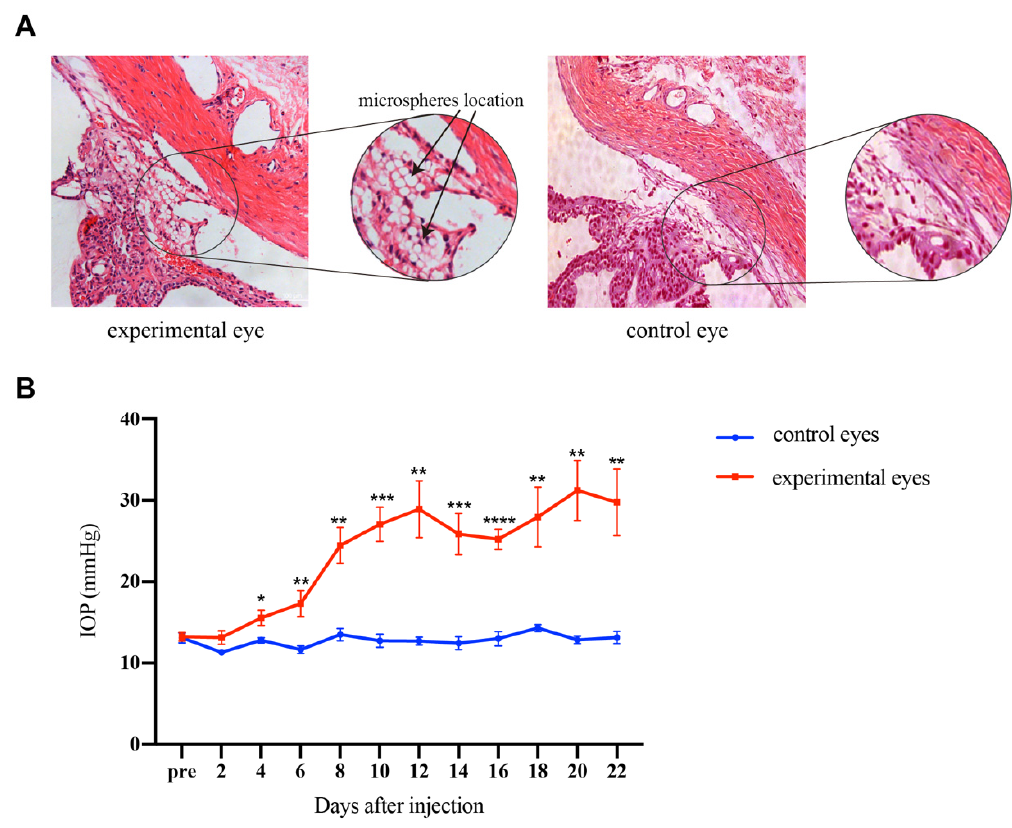
Figure 2. The distribution of microspheres in TM was viewed by HE staining, and the IOPs of rats were elevated by injection of microspheres. ( A ) HE staining of the experimental and control eyes. The magnified image showed the position of the injected microspheres, and the black arrow indicated the microspheres. The microspheres were located in the uveoscleral pathway between the sclera and ciliary body and in the corneoscleral angle, which were seen as transparent beads. ( B ) IOP changes in the experimental and control eyes of rats. On the 4th day after microsphere injection, the IOP in the experimental eyes was significantly higher than in the control eyes and elevated gradually with time. For comparison between groups, IOPs were compared every 2 days after injection, and p values were generated by the Student’s t -test. Scale bar: 100 µ m. * p < 0. 05, ** p < 0.01, *** p < 0.001, **** p < 0.0001.